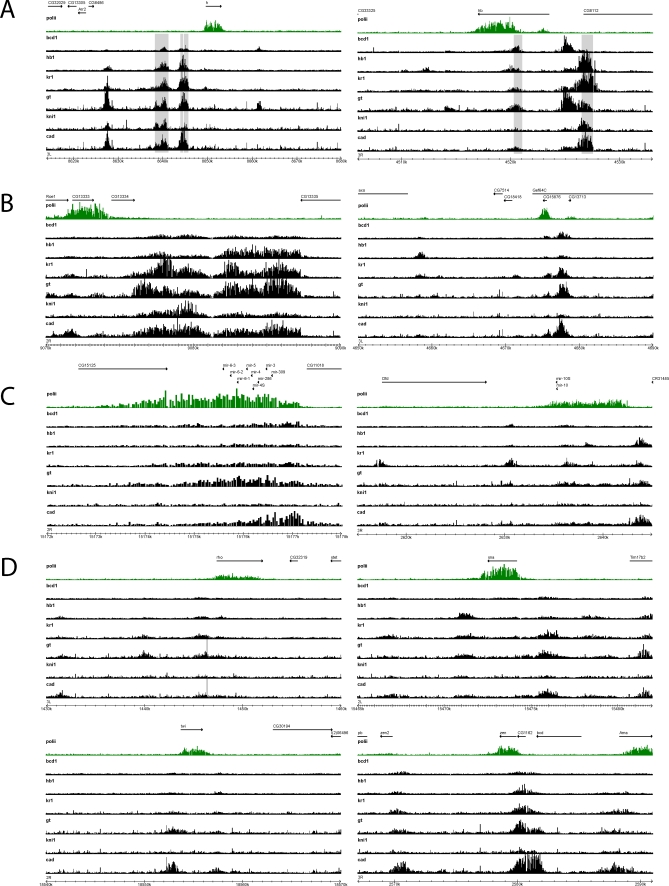
New Targets of Maternal and Gap Transcription FactorsChIP/chip oligonucleotide ratio scores for selected new targets.(A) Bound regions found near well-characterized A-P target genes hb and h, but which do not overlap known CRMs (shown in grey). For example, the binding 22 kb upstream of h is likely to be a novel h CRM because the other genes in proximity are not transcribed in the early embryo.(B) Genes transcribed in the early embryo that have no known function but are bound at moderate to high levels by multiple gap factors. In the left panel, CG13333/CG13334 loci, and the right, CG15876/CG13713 loci are shown.(C) miRNA genes that are actively transcribed in early embryos such as the gene that produces mir3, 4, 5, 6–1, 6–2, 6–3, 286, and 309 (left) and the mir-10 gene (right). See Table S3 for more details on binding to miRNA genes.(D) Binding in the region of D-V genes rho, twi, zen, and sna.